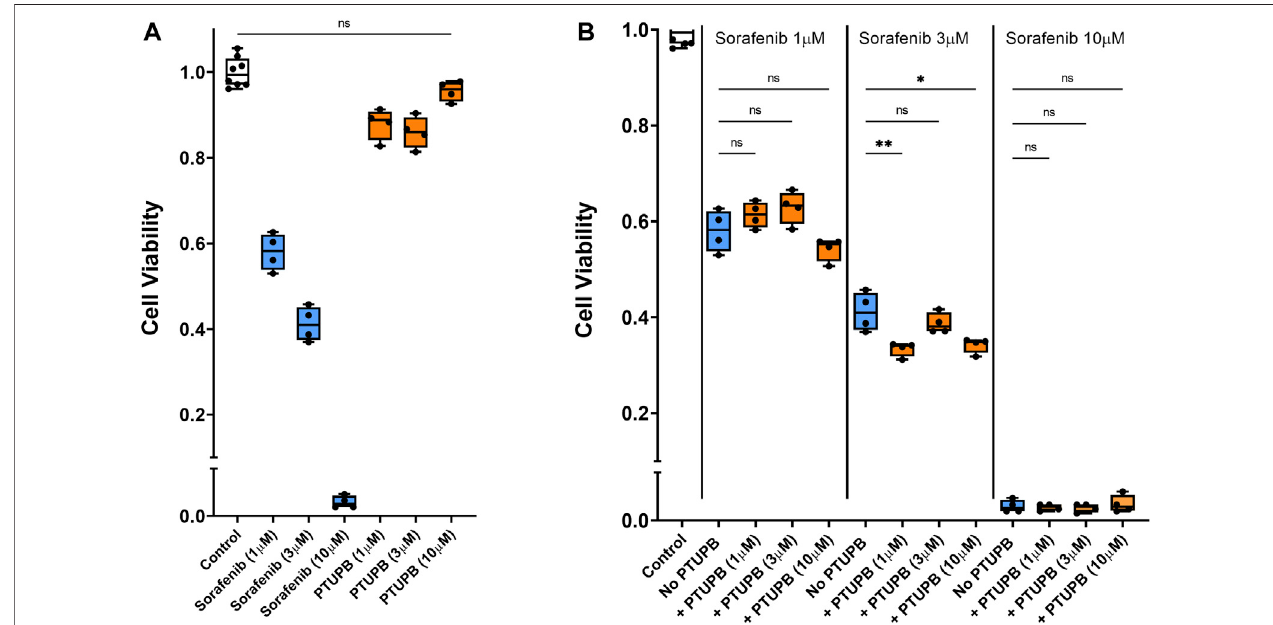
FIGURE 8 | Chemotherapeutic effectiveness. PTUPB did not interfere with the antitumor activity of sorafenib against the DU-145 prostate cancer cells. Sorafenib decreased viability of prostate cancer cells in a dose-dependent fashion, while PTUPB alone lacked cytotoxic effects in these cells (A) . In combination with sorafenib, PTUPBdid notinterferewiththeantitumor activity intheDU-145prostatecancercells (B) ( n (cid:1) 4).Dotsrepresenttheaverageofduplicatemeasuresforeachwell. ns p > 0.05, * p ≤ 0.05, ** p ≤ 0.01 determined by ANOVA followed by the Tukey post-hoc test. Data are reported as box and whisker plots with median, minimum to maximum, and 10 to 90